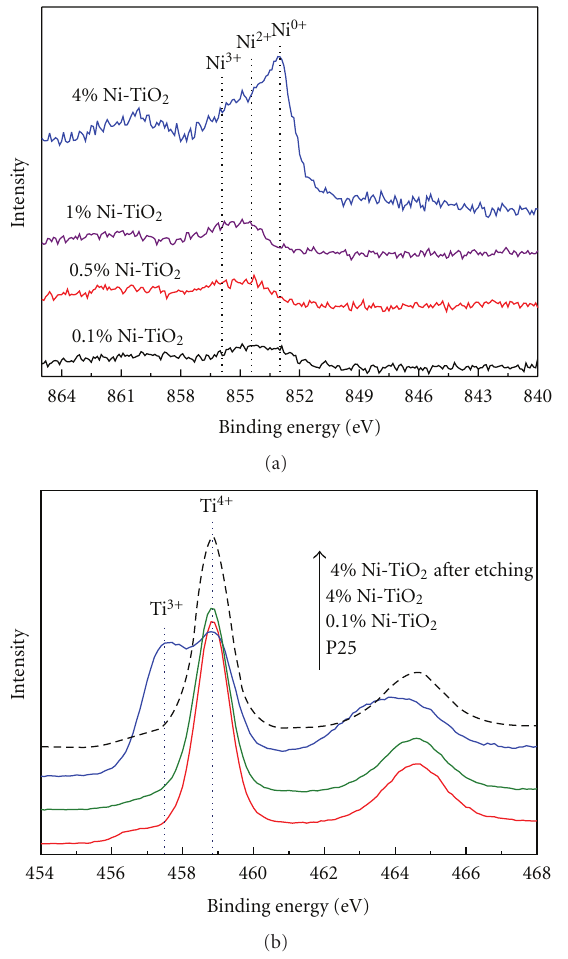
Figure 6: (a) XPS spectra over Ni 2p (b) Ti 2p of prepared samples.